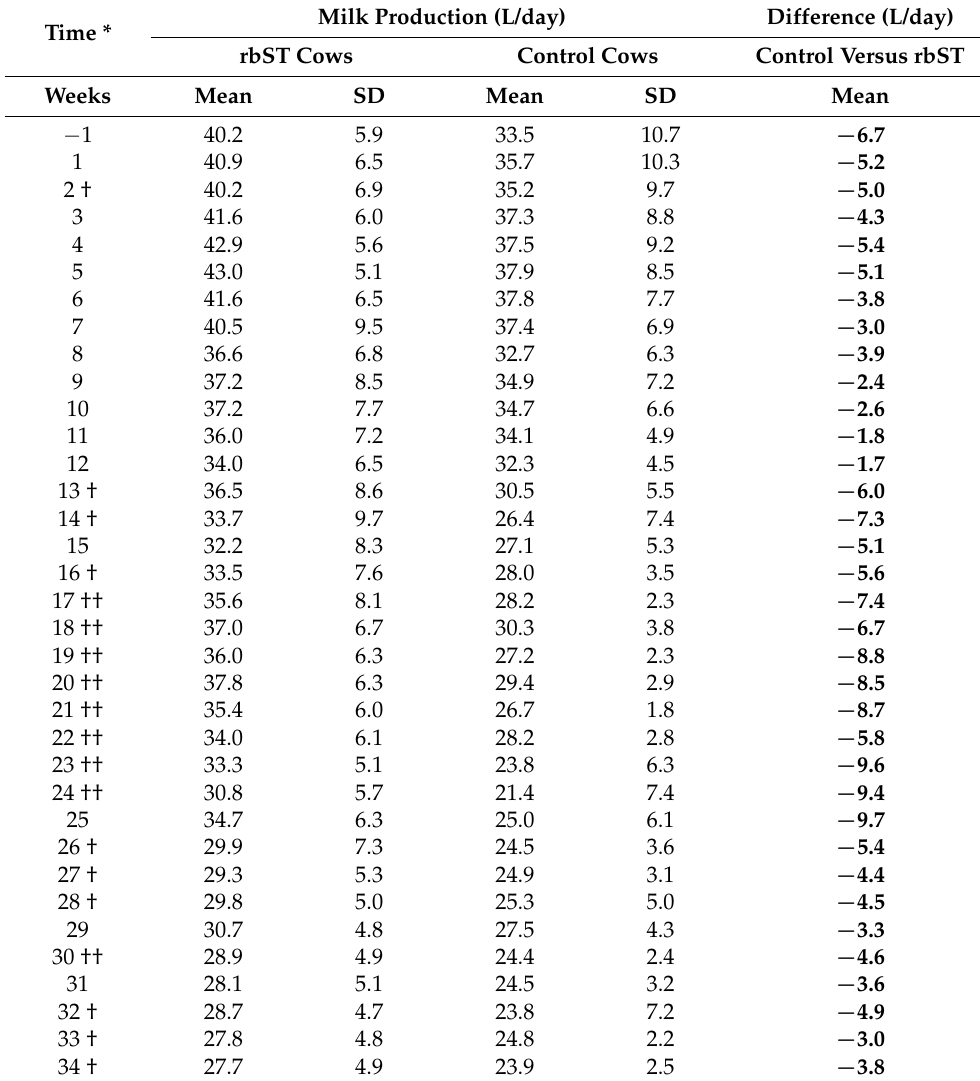
Table 12. Milk yield of the group of cows treated with recombinant bovine somatotropin (rbST) ( n = 6) and control ( n = 3) animals, over the course of 37 weeks (8